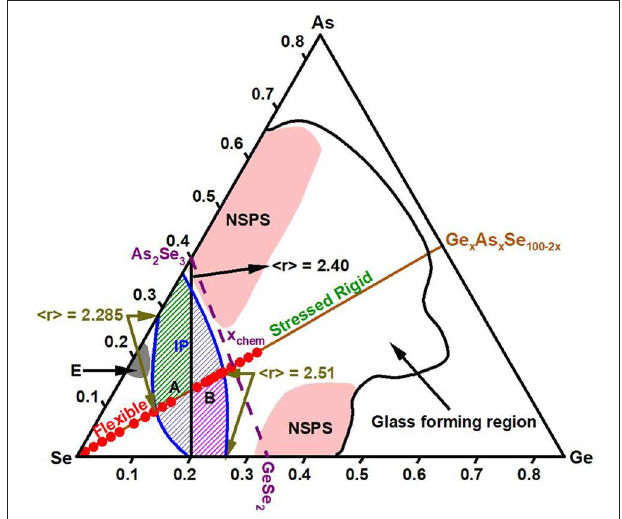
et al., 2012b ), As x Se 100 − x binary (Georgiev et al., 2000) and Ge x As x Se 100 − 2x ternary projected on the Ge-As-Se compositional triangle. The glass forming region is taken from ref. Z.U. Borisova ( Borisova, 1981). Starting from pure Se, as we move along the equimolar composition x , one spans the Flexible phase (0 < < r > < 2.285), the Intermediate Phase (2.285 < < r > < 2.51) followed by the stressed-rigid phase ( < r > > 2.51), and with the red data points showing the 20 glass compositions examined in the present study. Note the black line joining the As 2 Se 3 glass composition to the GeSe 4 one, is the locus of glass compositions with < r > = 2.40, and it splits the IP of the equimolar ternary into almost nearly equal parts, labeled A (hashed green) and B (hashed purple), with the segment A (B) nearly overlapping with IPs observed in As x Se 100 − x (Ge x Se 100 − x ) binary systems, respectively. The broken line of purple color, joining As 2 Se 3 to GeSe 2 composition, represents the join of chemical threshold compositions (x chem ), with NSPS setting in as x approaches x chem in both binary glass systems but not the present equimolar ternary as sketched. Feature E centered near x = 20% of As in the As x Se 100 − x join is the Eutectic in that binary system. See